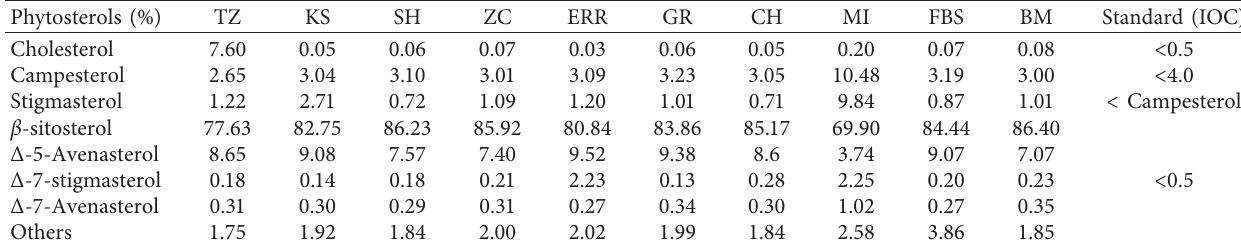
Table 4: Phytosterol composition of the studied